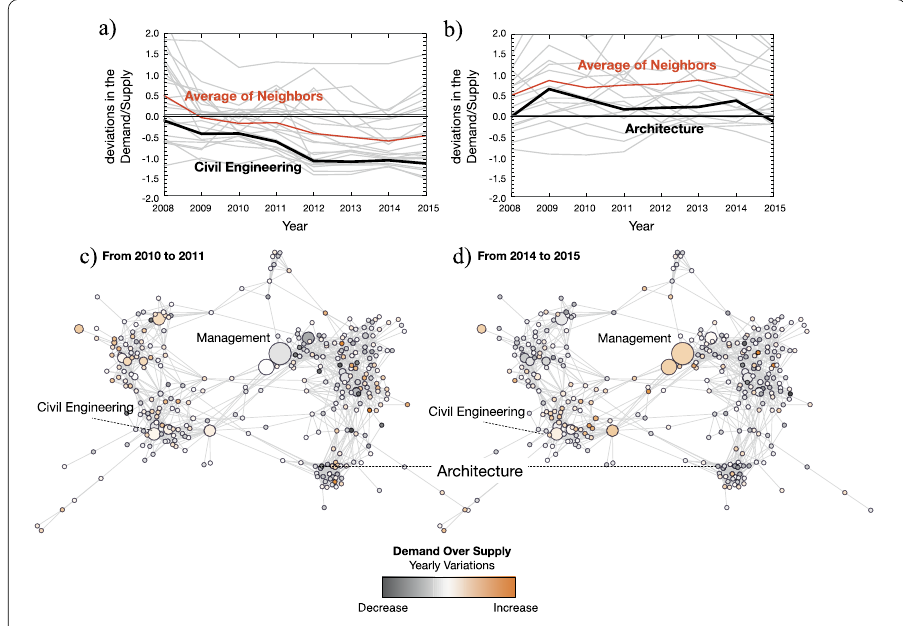
Figure 4 Time variations and spillovers in the demand-supply ratio for Civil Engineering ( a ) and Architecture ( b ) and their direct neighbours, in the Portuguese Higher Education Network (PHES). The complete PHES network is colored according to the observed demand-supply ratio yearly variation between 2010/11 ( c ) and between 2014/15 ( d ). Two illustrative examples are shown that capture the variation in demand in a period when the number of applicants was in a clear decline ( c ) and another when it was growing ( d ) in the PHES. Orange denotes a positive variation (increase in demand-supply), black a negative variation (decrease in